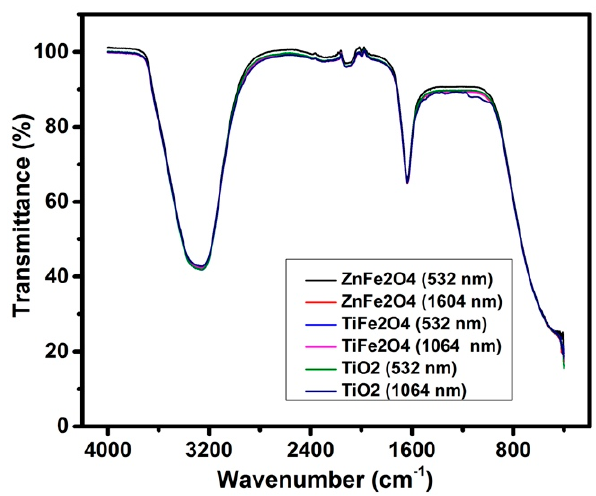
Figure 4. Fourier transform infrared spectroscopy (FTIR) transmittance spectra of MONPs produced with laser ablation technique in water at 1064 and 532 nm of wavelength.